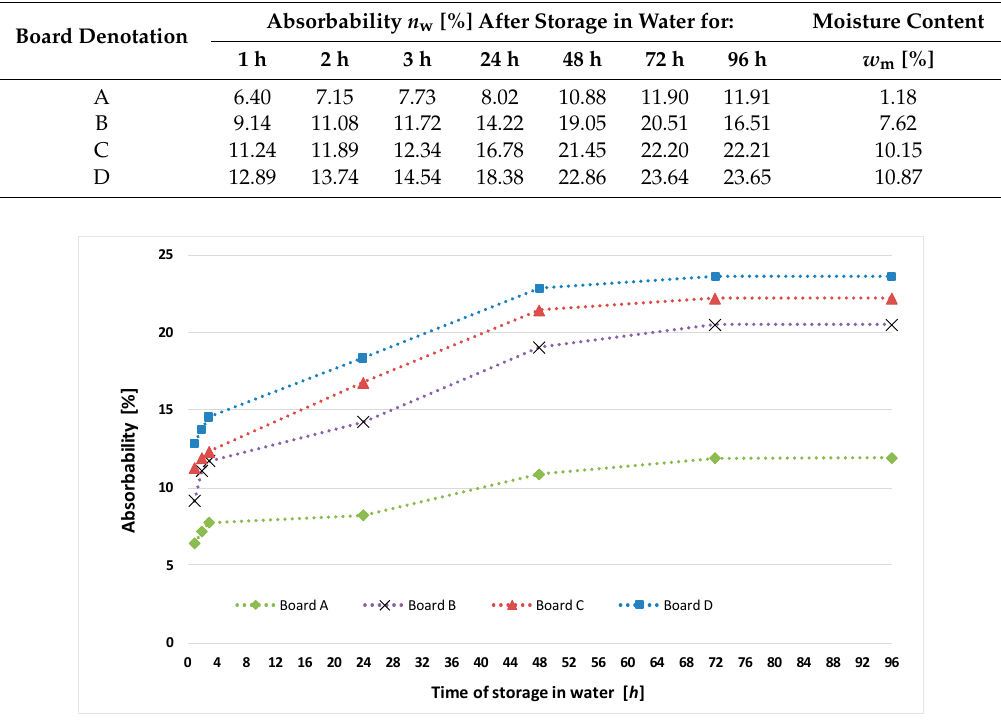
Figure 1. Increase in absorbability n w over storage time in water for tested boards.